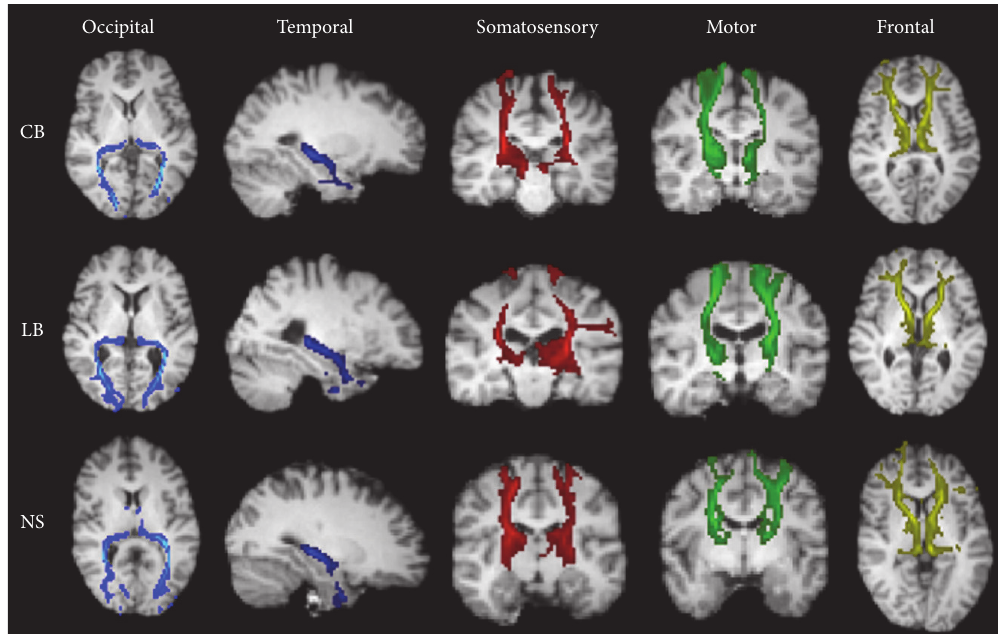
Figure 3: Examples of cortical white matter projections from each of the five thalamic clusters to the cortical target masks in a CB, LB, and NS participant. The cortical target masks are defined from the Desikan-Killiany atlas provided with FreeSurfer, as described in Table 1. The tracts are overlaid on each subject’s T1-weighted image and presented in a slice of the most representative view, axial or